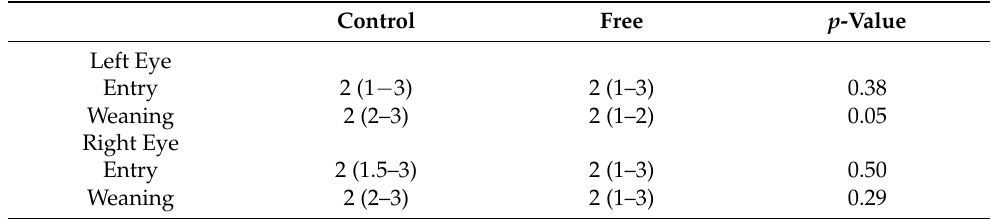
Table 3. Tear stain scores for both the left and right eyes for sows in both treatments, at entry to the farrowing rooms and at weaning. Data are presented as medians and inter-quartile ranges. Control Free p